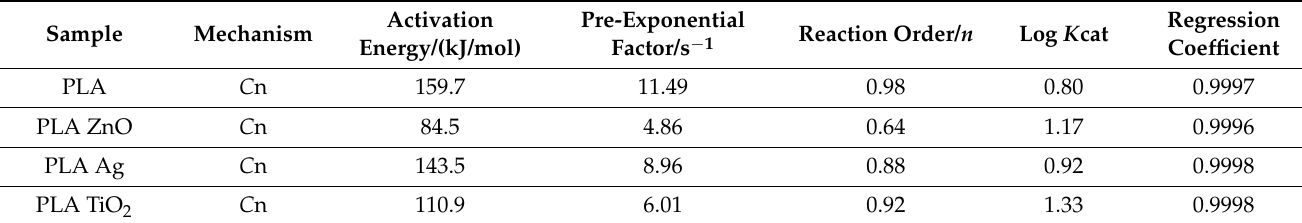
Table 3. Activation energy, pre-exponential factor, and reaction order of neat PLA and PLA composites.